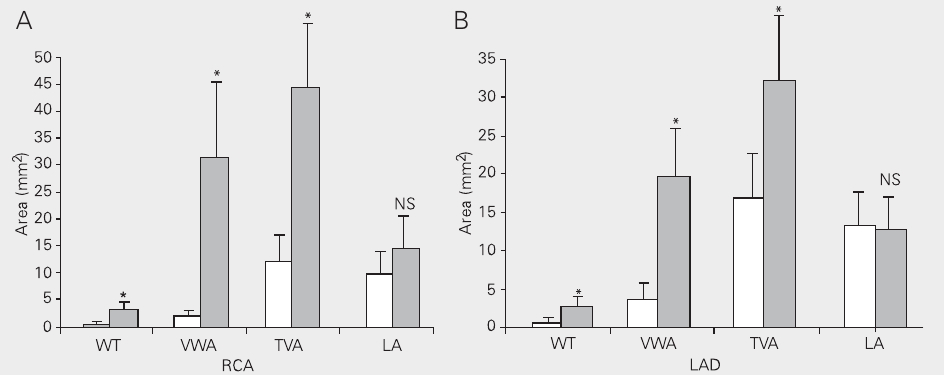
Figure 2. Areas of the right cor- onary artery (RCA) (A) and left anterior descending artery (LAD) (B) parameters obtained by magnetic resonance imag- ing. Patients: filled columns; control subjects: open columns. WT = wall thickness (mm); LA = luminal area (mm 2 ); VWA = ves- sel wall area (mm 2 ); TVA = total vessel area (mm 2 ); NS = not significant. *P < 0.001 com- pared to control (Student t